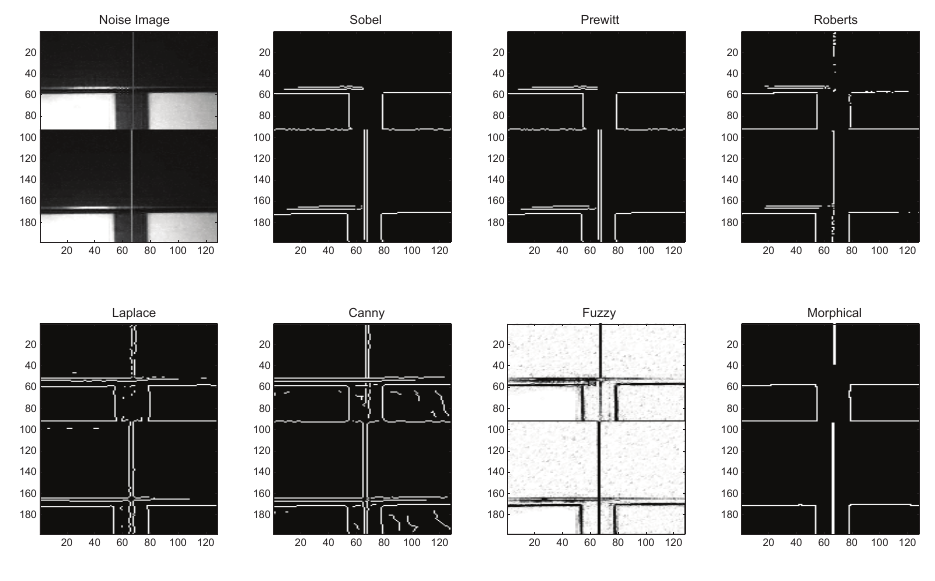
Figure 10. Comparison between conventional and the proposed methods for edge detection in noisy gap